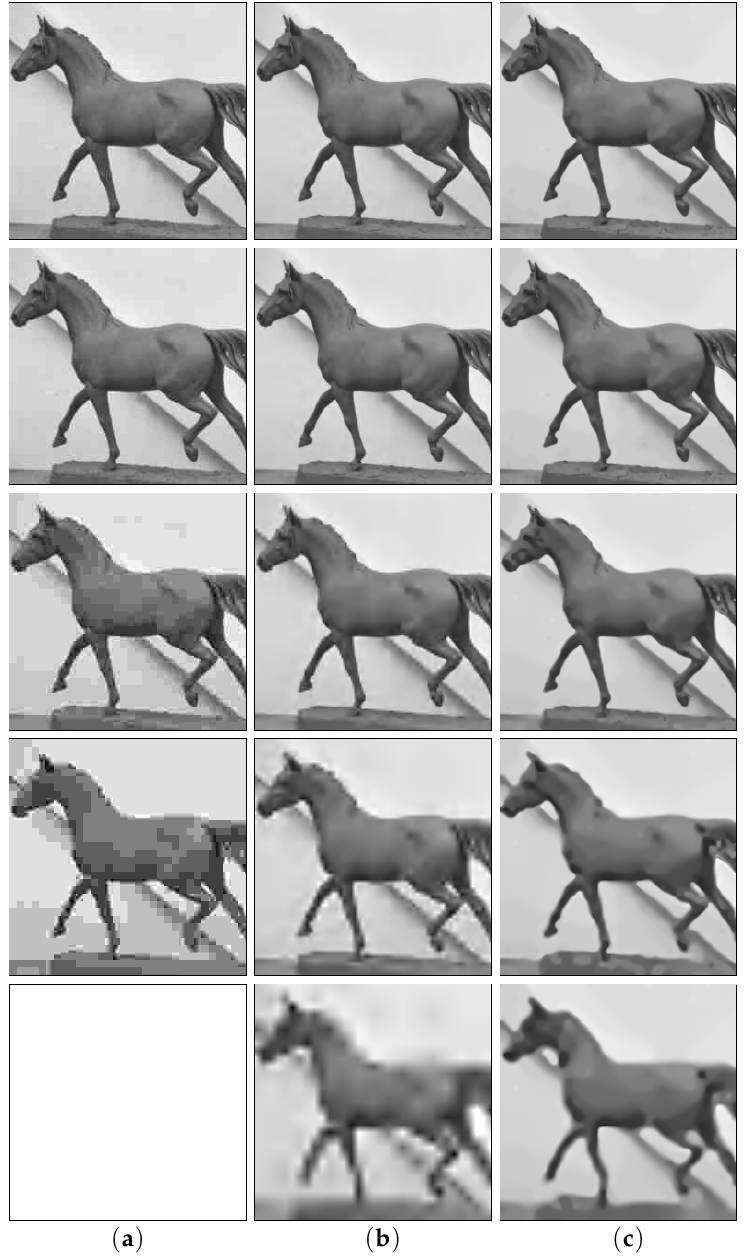
Figure 14. Comparative overview of reconstructed images for image horse ranging from 0.8 bpp ( top row ) to 0.05 bpp ( bottom row ). Compression methods: ( a ) JPEG, ( b ) JPEG 2000, and ( c ) EEDC-BSSP. Table 11. Results of the VIF metric for image horse